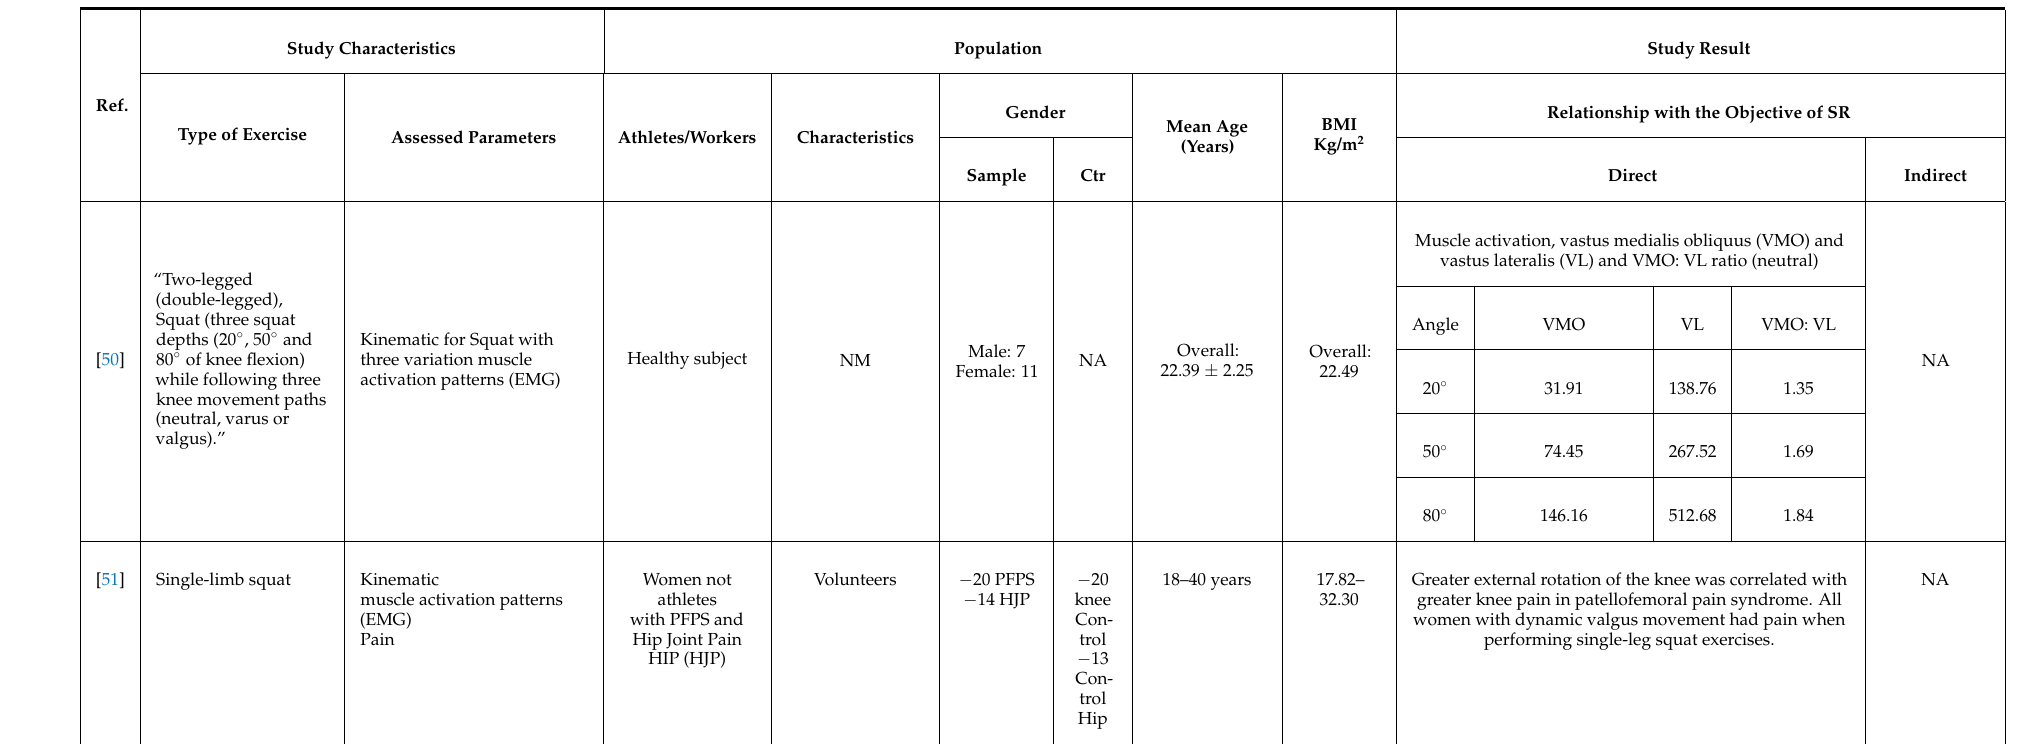
Greater external rotation of the knee was correlated with greater knee pain in patellofemoral pain syndrome. All women with dynamic valgus movement had pain when performing single-leg squat